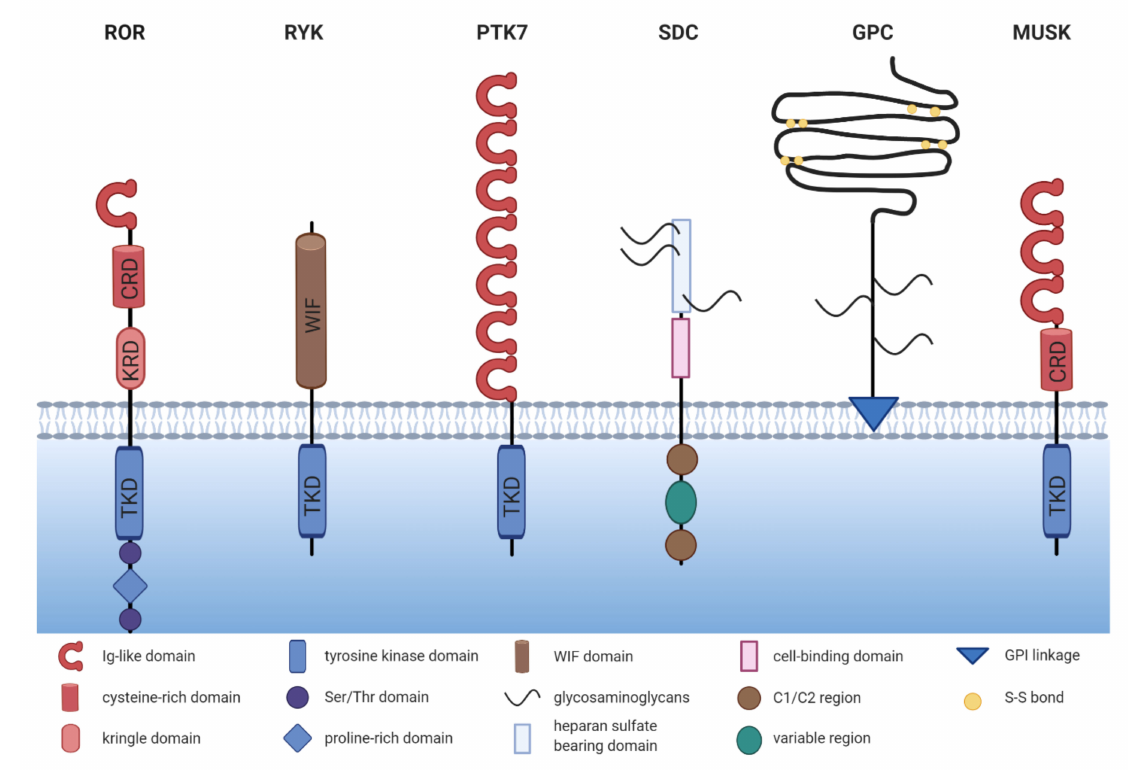
Figure 1. The structure of non-canonical WNT co-receptors. Comparison of the schematic structures of potential non- canonical WNT co-receptors. ROR = receptor tyrosine kinase-like orphan receptor, RYK = receptor tyrosine kinase, PTK7 = protein tyrosine kinase 7, SDC = syndecan, GPC = glypican, MUSK = muscle-specific kinase, TKD = tyrosine kinase domain, KRD = kringle domain, CRD = cysteine-rich